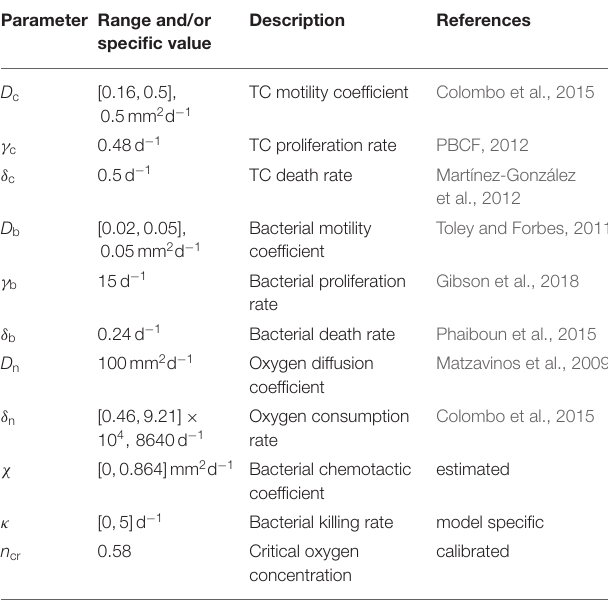
TABLE 1 | Summary of the parameter values considered in the model simulations. Parameter Range and/or specific